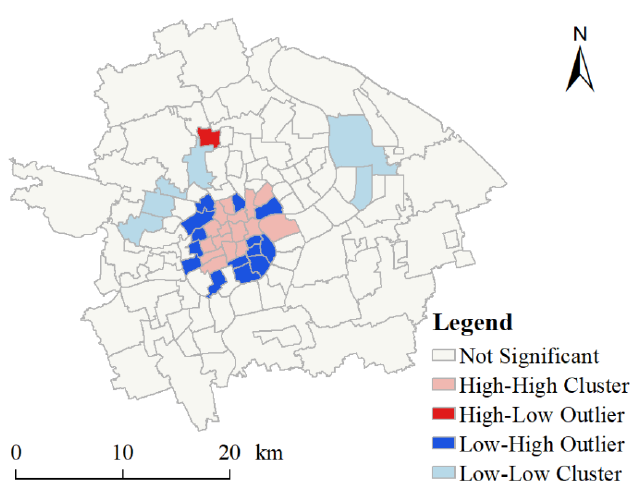
Figure 4. Distribution of the nighttime economy – housing imbalance intensity.